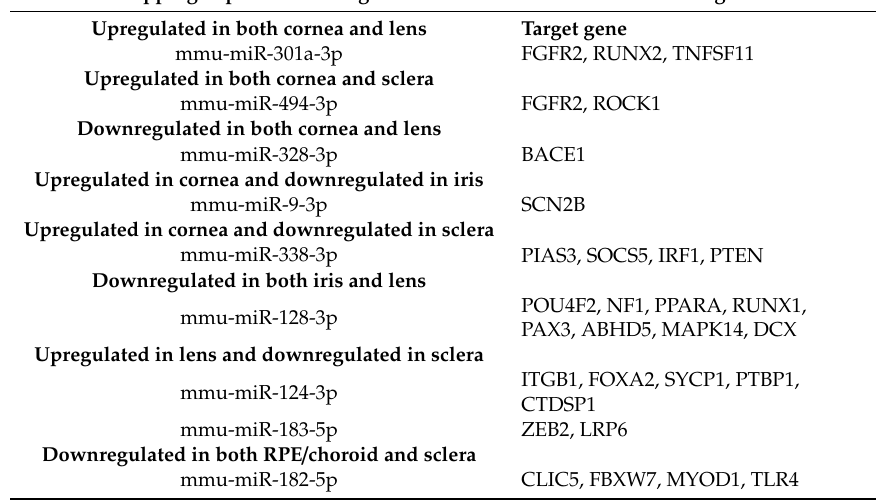
Table 13. The overlapping expression changes in miRNAs found in two ocular tissues and their target genes.